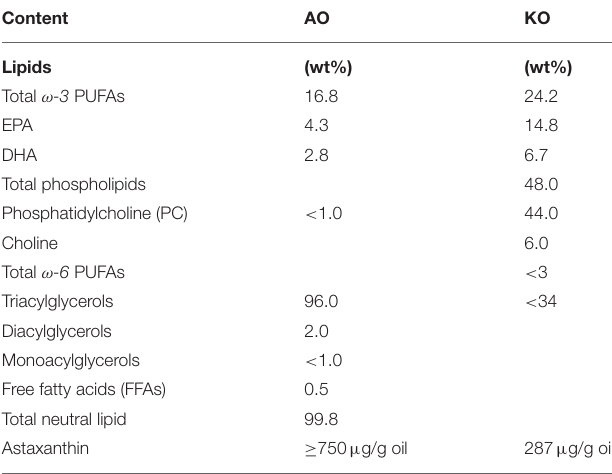
TABLE 1 | Average composition of astaxanthin oil (AO) and Krill oil